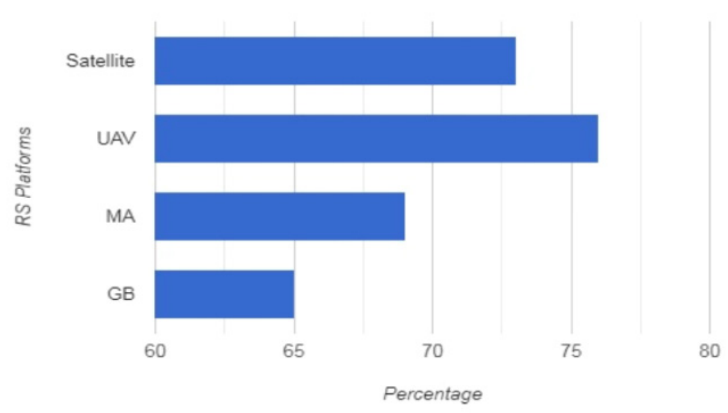
Figure 11. Precision accuracy rate.